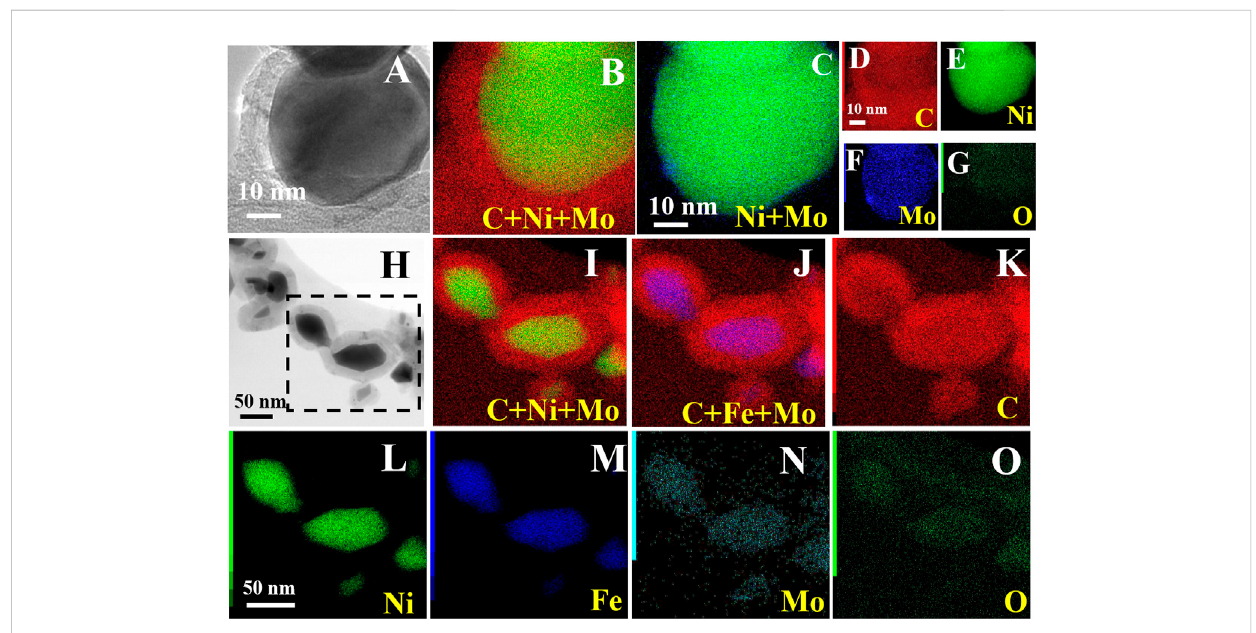
FIGURE 4 HRTEM image/bright fi eld TEM images and the corresponding elemental mapping of C, Ni, Mo and O for NiMoC@C (A – G) and C, Ni, Fe, Mo and O for NiFeMo 2 C@C (H – O)